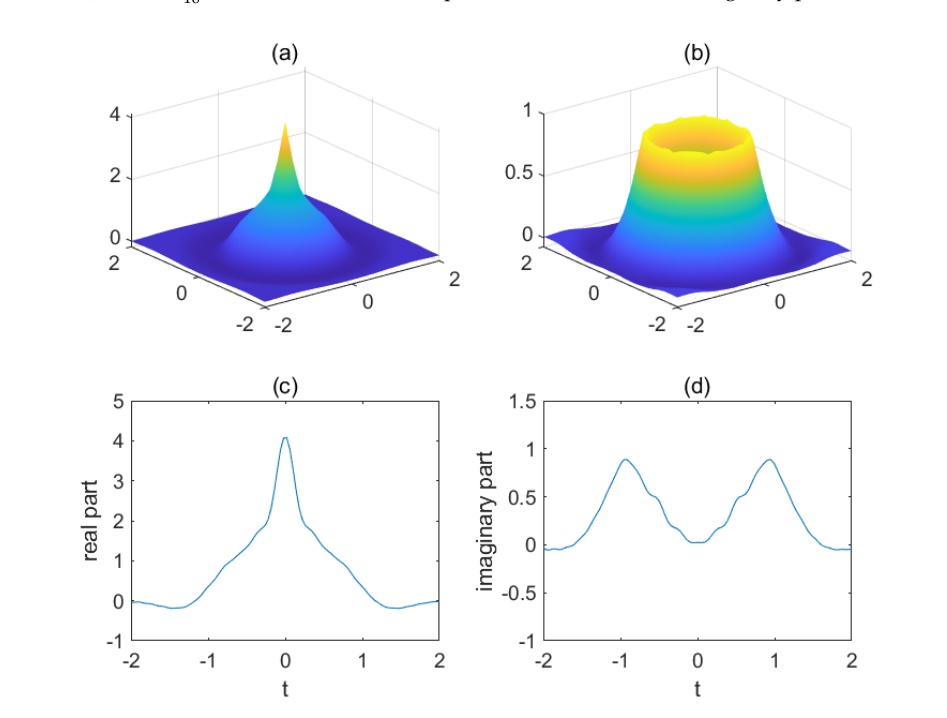
Figure 2. ( a ) Real part graph of g α ( x , y ) with α 1 = α 2 = π α 1 = α 2 = π , ( c ) Section view of real part, ( d ) Section view of imaginary 5